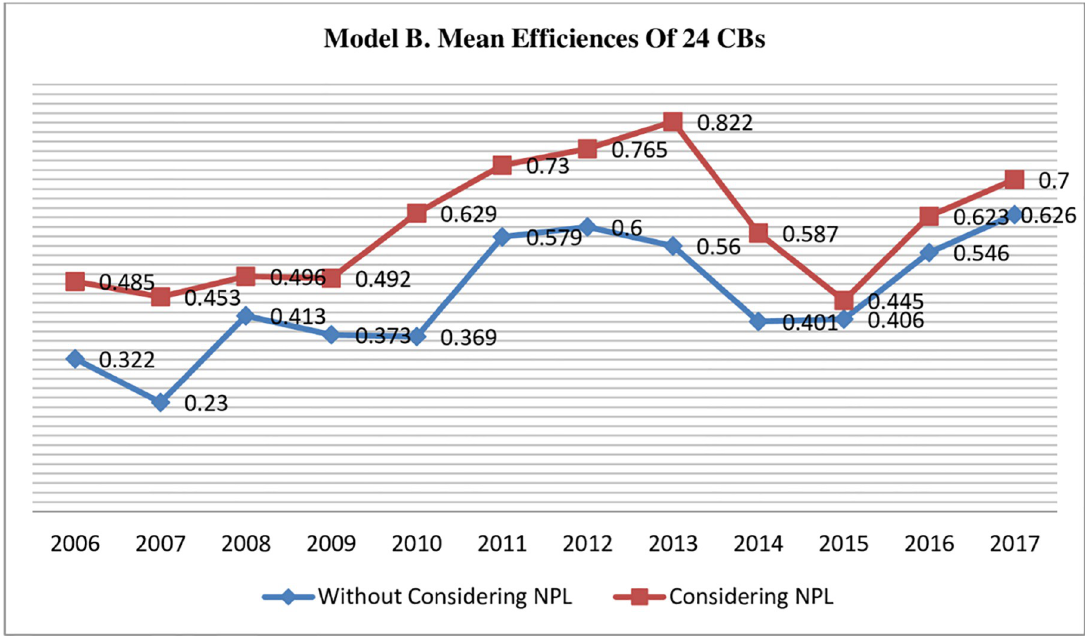
Fig 4. Model B comparison of mean efficiency scores of all CBs estimated with and without incorporating undesirable output NPLs.